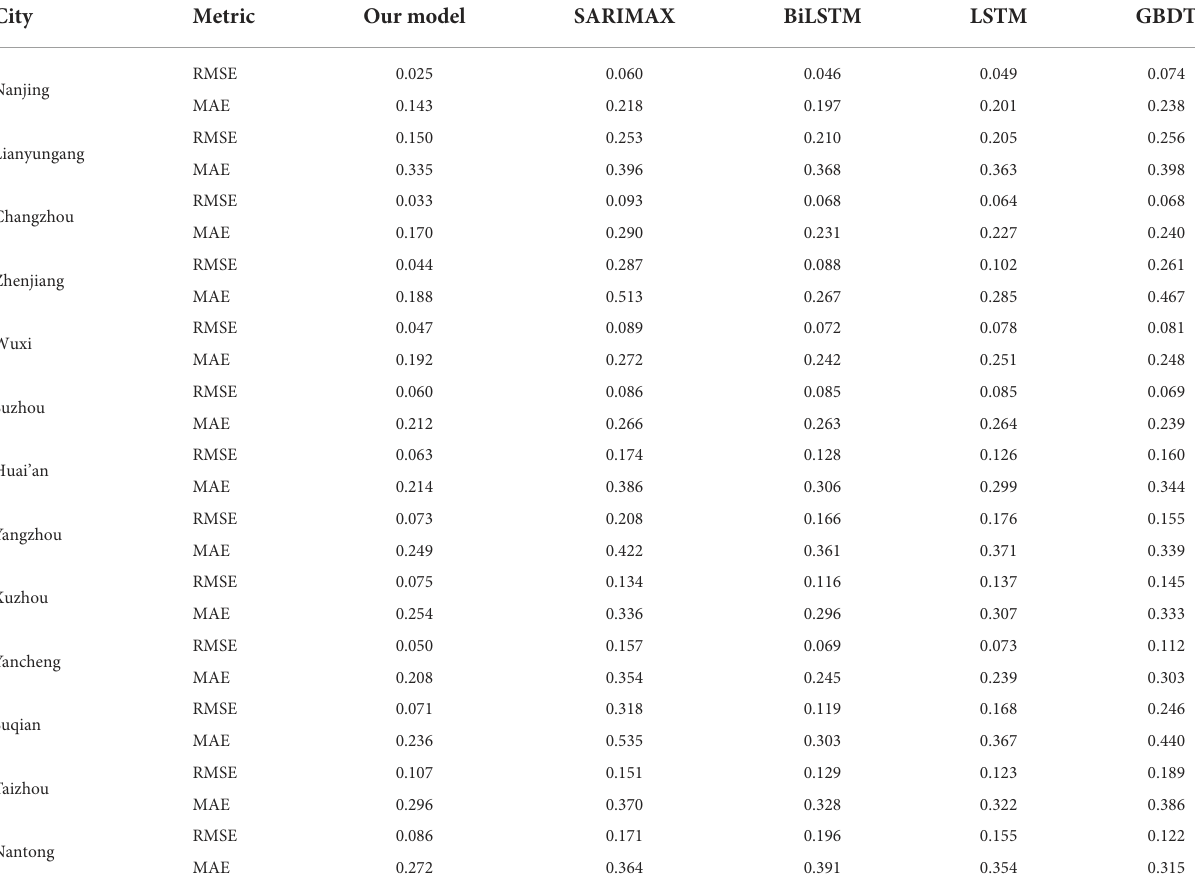
TABLE 3 The comparison results of different models on predicting monthly incidence rates of hepatitis E for the 13 cities in Jiangsu province. City Metric Our model SARIMAX BiLSTM LSTM